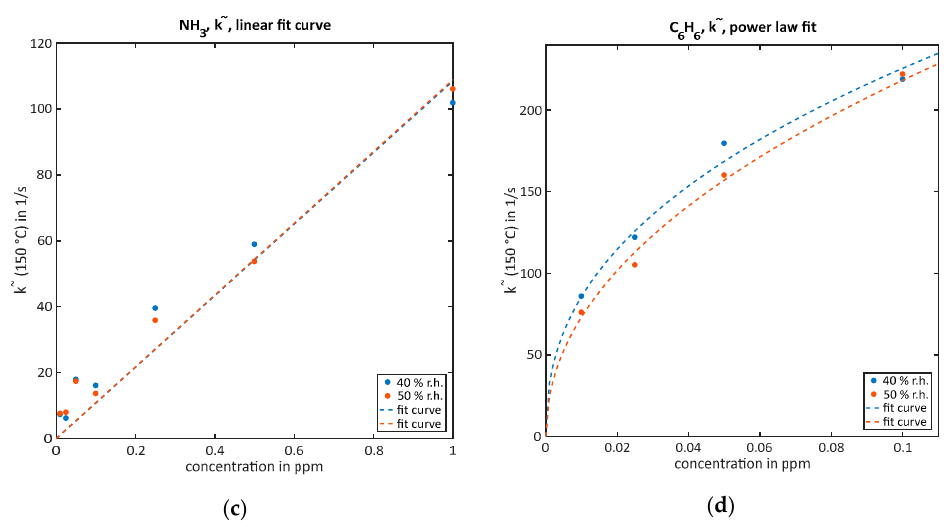
Figure 3. Quantification of the correspondent gases via the (cid:101) k -evaluation and their fit curves for both humidities: ( a ) CO, linear fit curve; ( b ) H 2 , linear fit curve; ( c ) NH 3 , linear fit curve; ( d ) C 6 H 6 , power law fit.